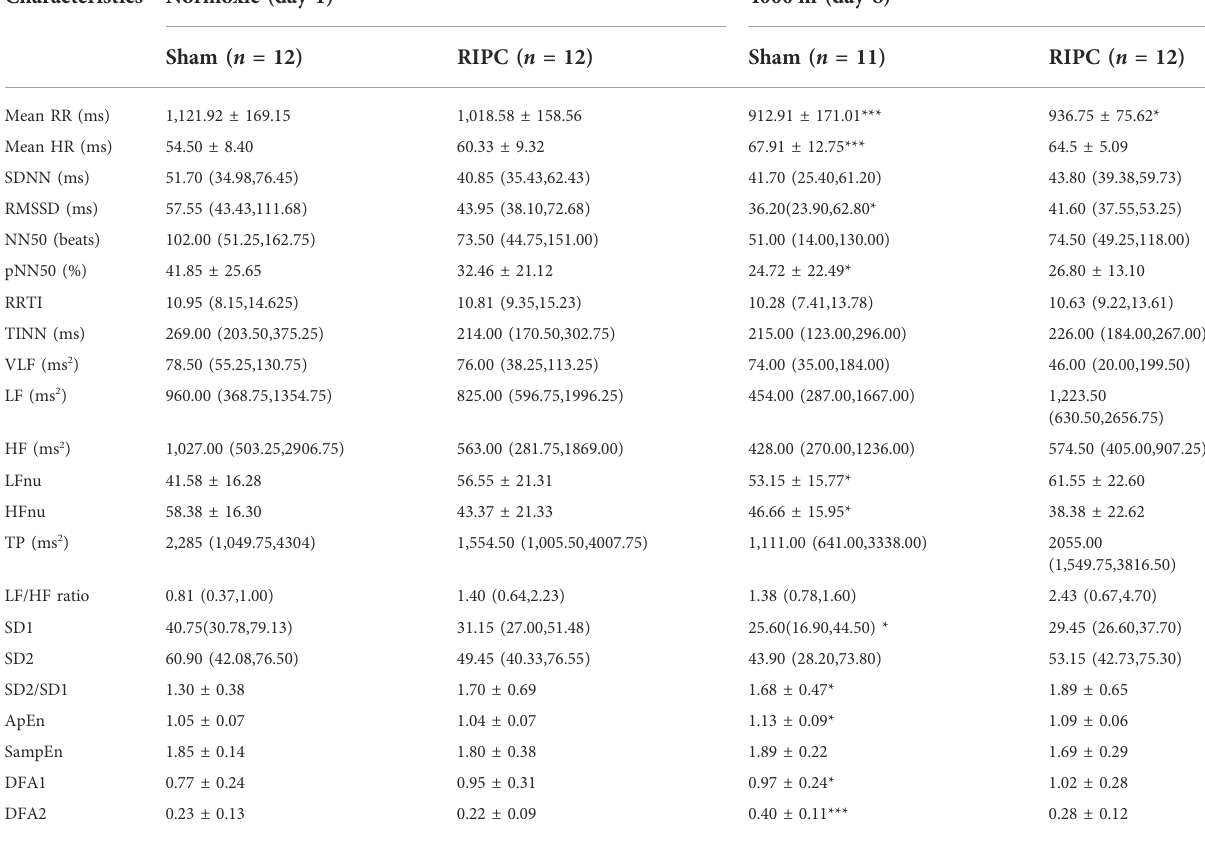
TABLE 3 The changes of heart rate variability at rest under the normoxic and HH conditions. Characteristics Normoxic (day 1)